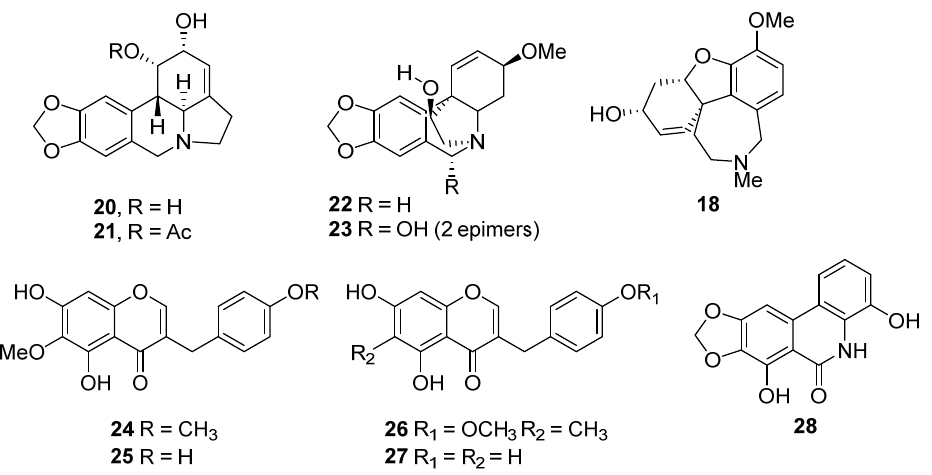
Figure 6. Chemical structures of selected compounds from Crytanthus . Zephyranthine ( 20 ), 1,2- O-diacetylzephyranthine ( 21 ), haemanthamine ( 22 ), haemanthadine ( 23 ), galanthamine ( 18 ), 5,7-dihydroxy-6-methoxy-3-(4 ꞌ -methoxybenzyl)chroman-4-one ( 24 ), 5,7-dihydroxy-6-methoxy-3-(4 ꞌ -methoxybenzylidene)chroman-4-one ( 25 ), 5,7-dihydroxy-6-methoxy-3-(4 ꞌ hydroxybenzyl)chroman-4-one ( 26 ), 5,7-dihydroxy-3-(4 ꞌ hydroxybenzylidene)-chroman-4-one ( 27 ) and naciprimine ( 28 ).